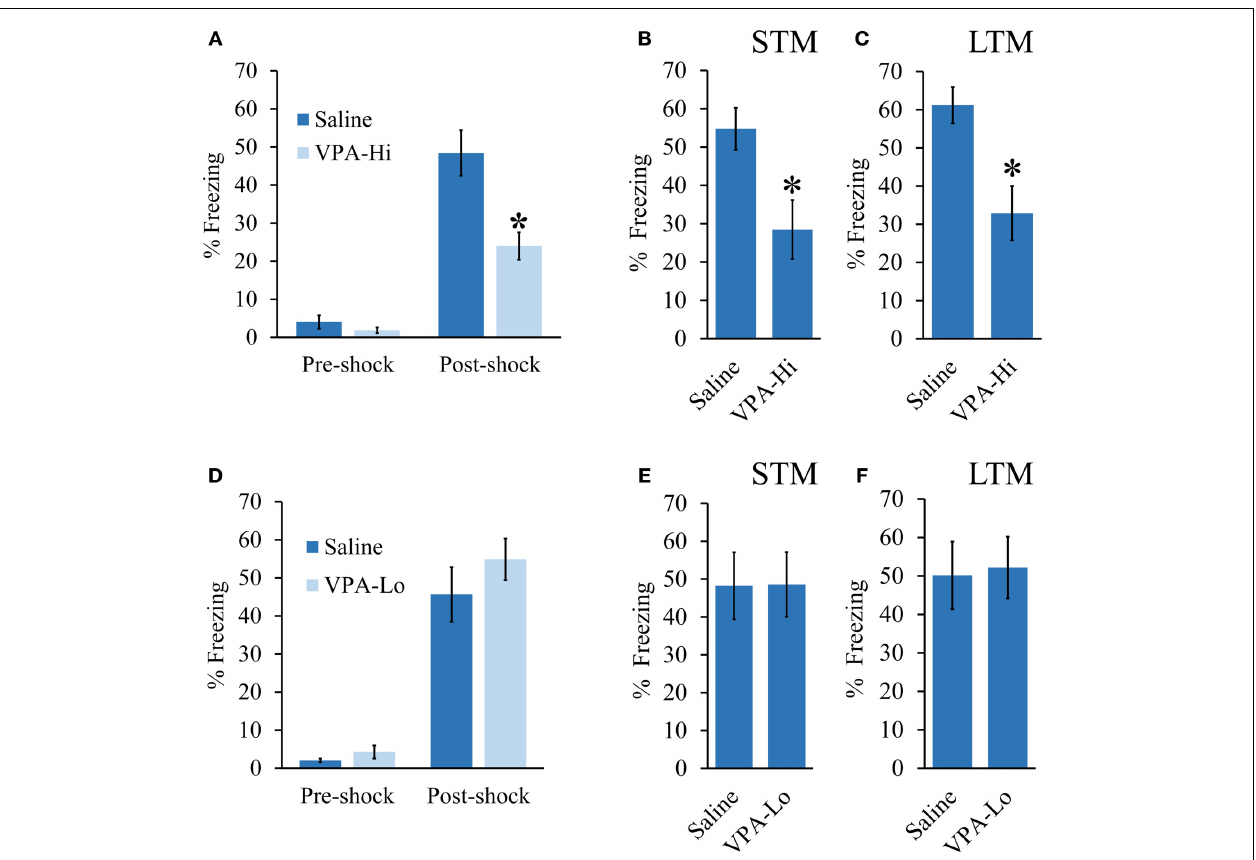
FIGURE 1 | Progeny from VPA exposed dams exhibit a dose dependent effect on fear learning: (A–C) Progeny from VPA-Hi and saline exposed dams were auditory fear conditioned (Saline = 16, VPA-Hi = 13). (A) Pre and post shock freezing was assessed immediately before and after exposure to tone-shock, respectively. (B) Auditory fear memory assessed 3h post fear conditioning (i.e.,